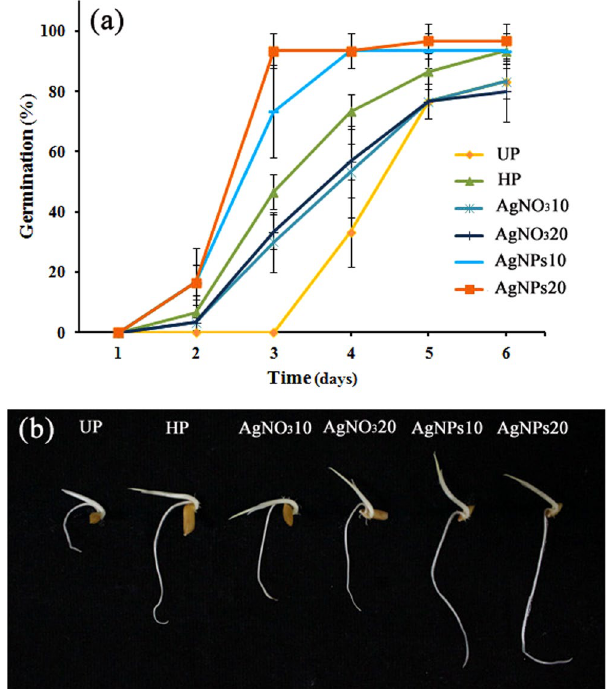
Figure 4. Germination rate of rice seeds after priming with different priming agents ( a ) and phenotype of rice seedlings after 6 day germination ( b ). Data are presented as means of three replicates containing 10 seeds each ± standard error of means. (Abbreviations of each treatment are defined in materials and methods).